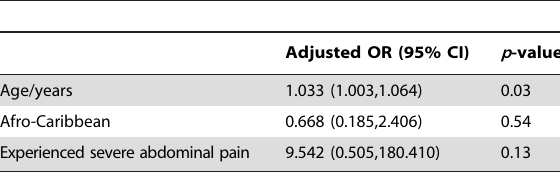
Table 2. Multivariable associations with